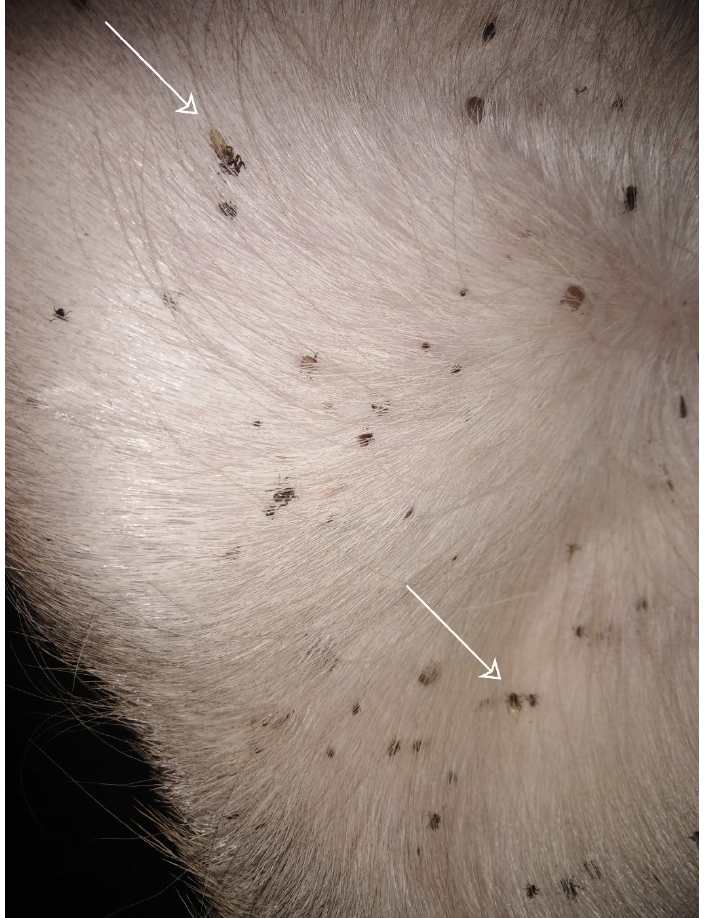
Figure 2. Hippobosca equina specimens (arrows) found in groin on red deer calf (photo by Weronika Ma ś lanko). Other H. equina hosts include camels, rabbits [69], hares, moose, roe deer, grey herons [34,70], northern goshawks [71], goats [49,52], pigeons [20,72], and even dogs [3,24]. Some